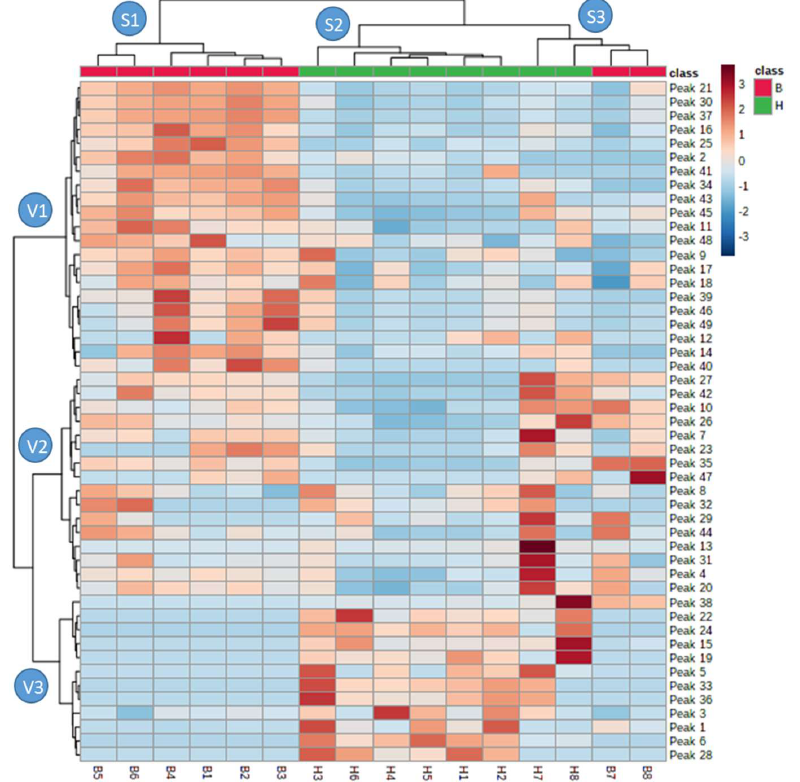
Figure 2. Hierarchical clustering analysis via heatmap using the areas under the curve of the 49 chemical compounds detected in the 16 cocoa by-product extracts.